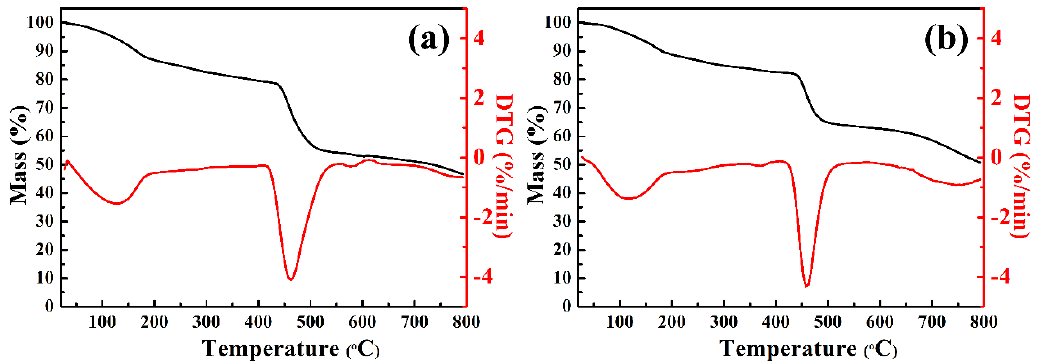
Figure 9. The thermogravimetric (TG) and DTG curves of PAA-AM ( a ) and PAA-AM/FA ( b ).